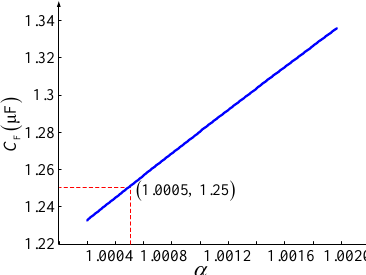
Figure 12. The relationship between C F and α .